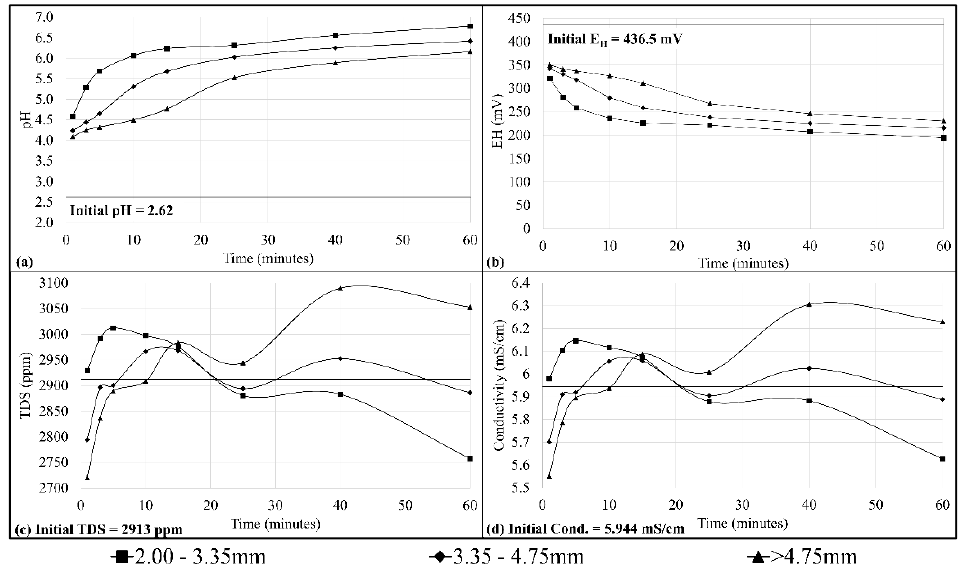
Figure 8. Effect of particle size on ( a ) pH; ( b ) E H ; ( c ) TDS; and ( d ) conductivity after 1-h contact.